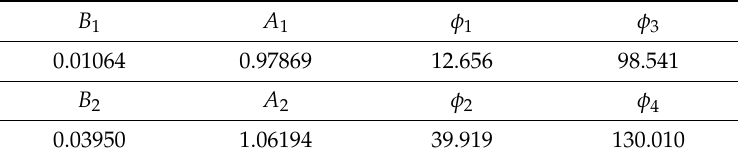
Table 1. The calibration results of the unknown parameters.